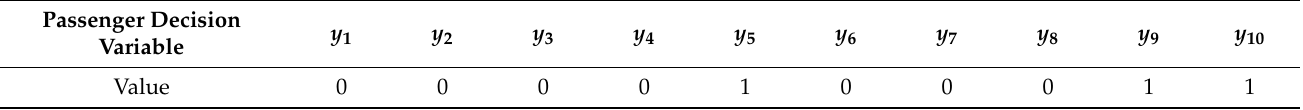
Table 10. Solution y for passengers when r D = r P = 0.1.